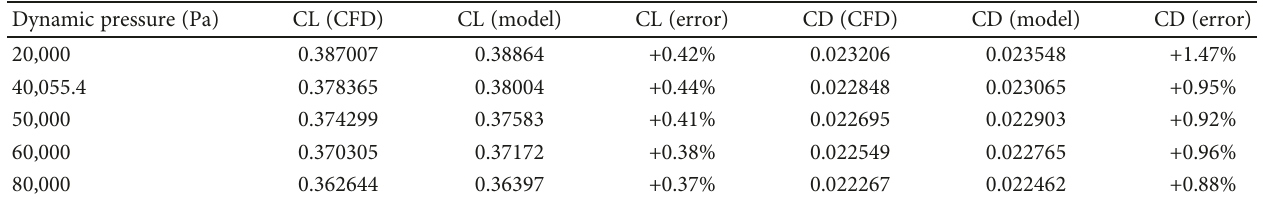
Table 8: The comparison of the aerodynamic force coe ffi cient by the CFD/CSD method and modeling method. Dynamic pressure (Pa)